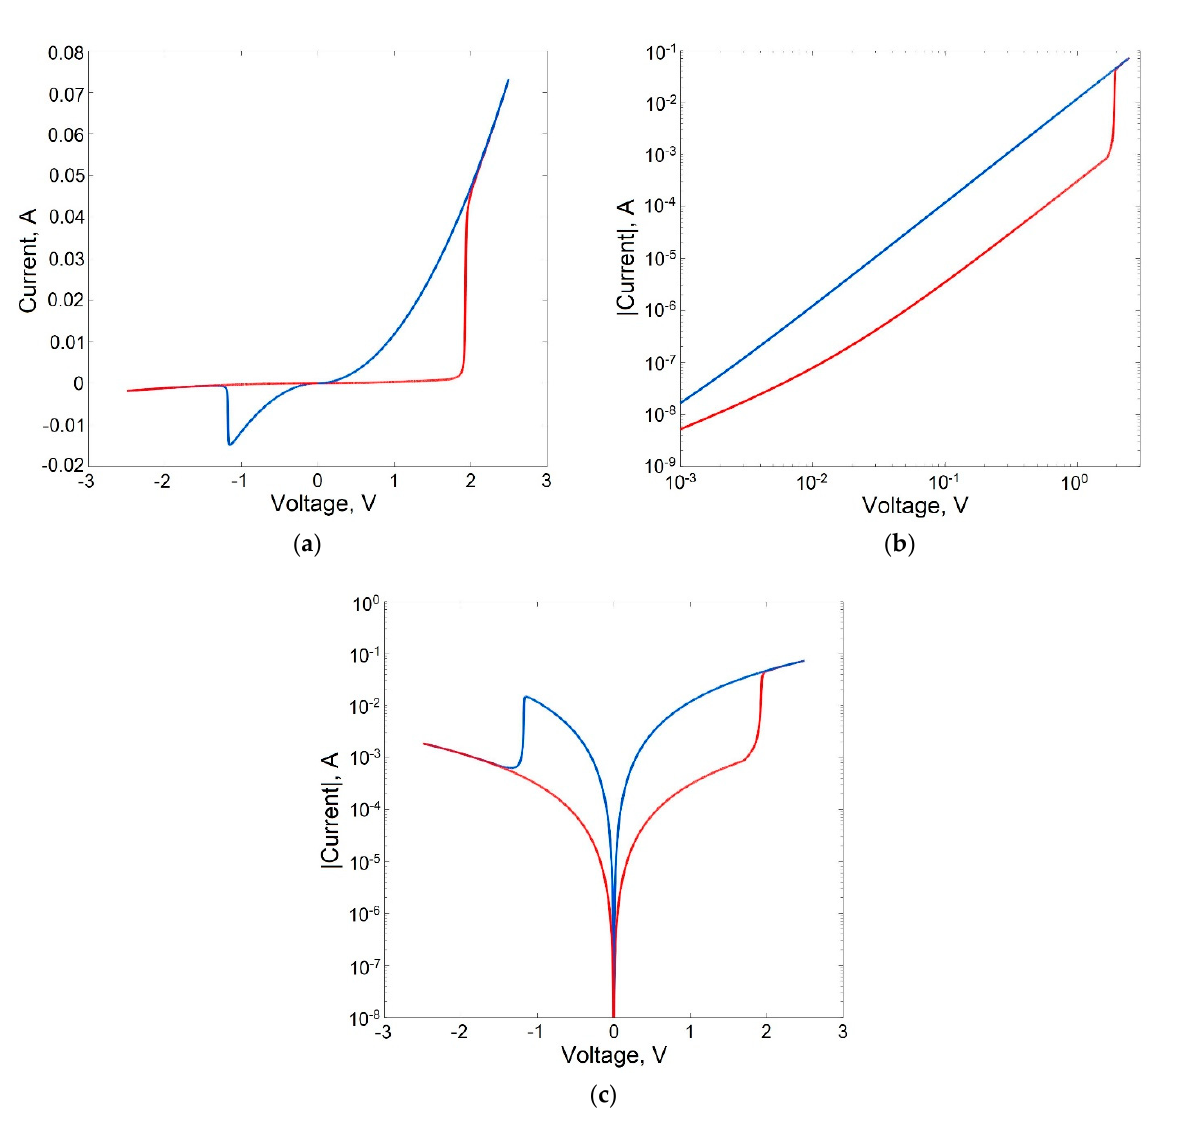
Figure 3. I–V characteristics of a memristive element in linear ( a ), logarithmic ( b ) and semilogarithmic ( c ) scales.